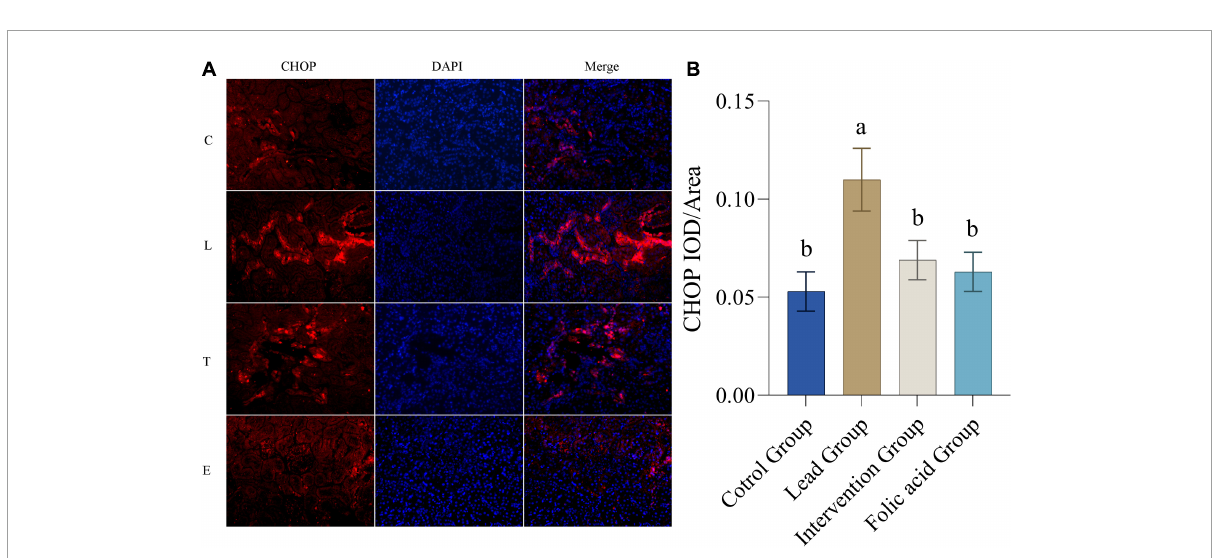
FIGURE5 Effect of folic acid on the expression of C/EBP-homologous protein (CHOP) protein in the kidney of lead exposed rats. (A) Immunofluorescence results of CHOP protein expression (200 × ). (B) The expression level of CHOP protein is represented by the average integrated optical density value ( n = 6). C: control group; L: lead-exposed group; T: intervention group; E: folic acid group. Data were presented as mean ± SD. Different superscript letters indicate differences ( P <